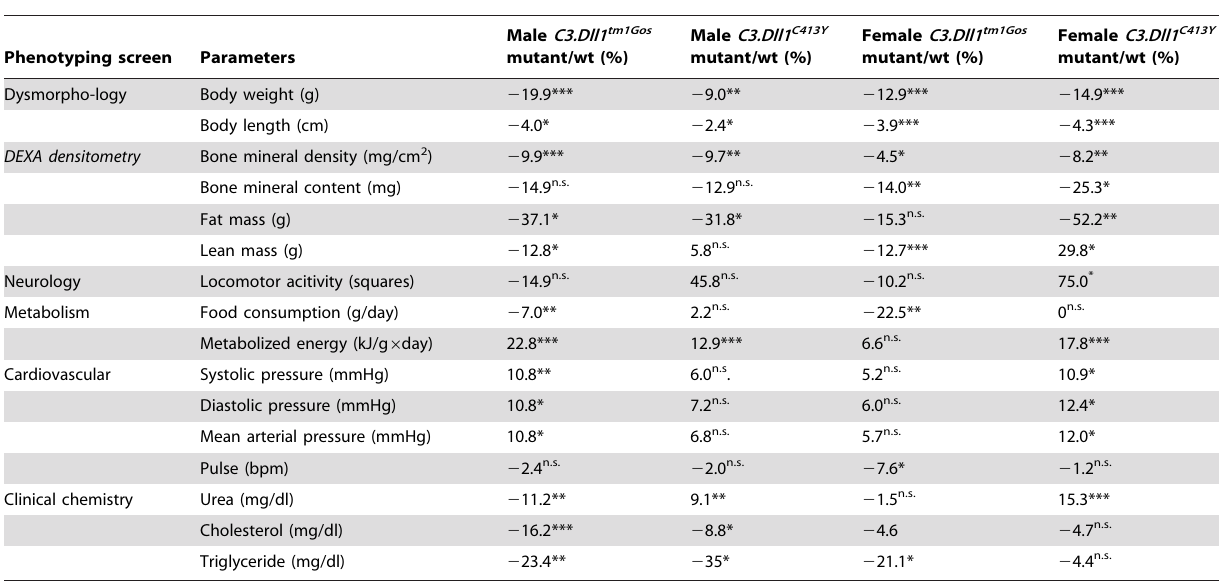
Table 4. Comparison of the variant phenotypes due to the C3.Dll1 tm1Gos and C3.Dll1 C413Y alleles.